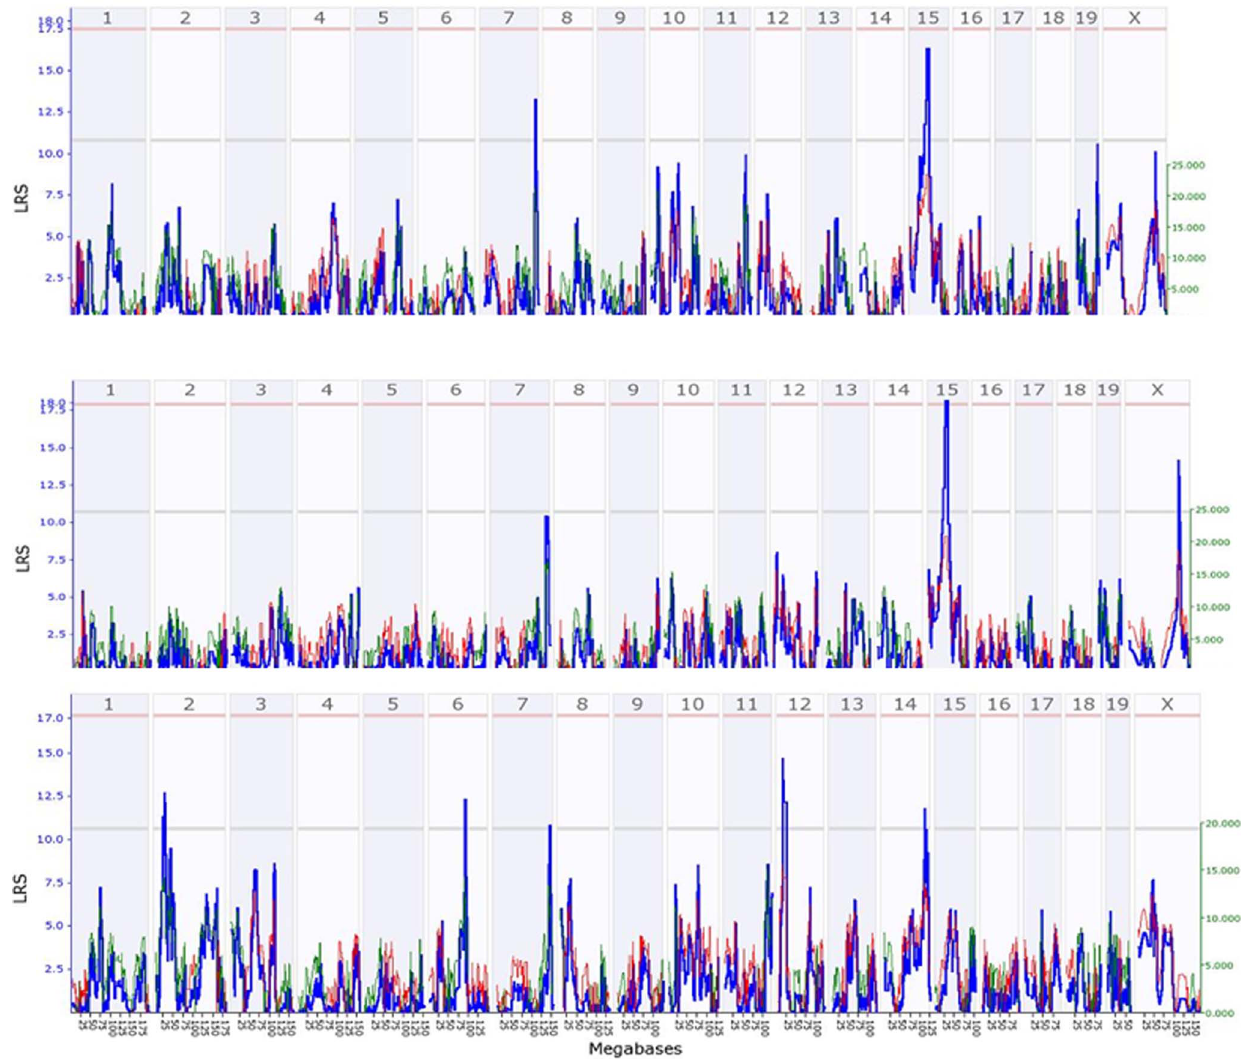
Figure 1. QTL of BMD of the femur and tibia in female and male mice. The numbers on top of each figure indicate the number of chromosome. Numbers on left vertical bar indicate the LRS values. Figure 1A. QTL of BMD detected for femur in male mice. Figure 1B. QTL of BMD detected for tibia in male mice. Figure 1C. QTL of BMD detected for femur in female mice.